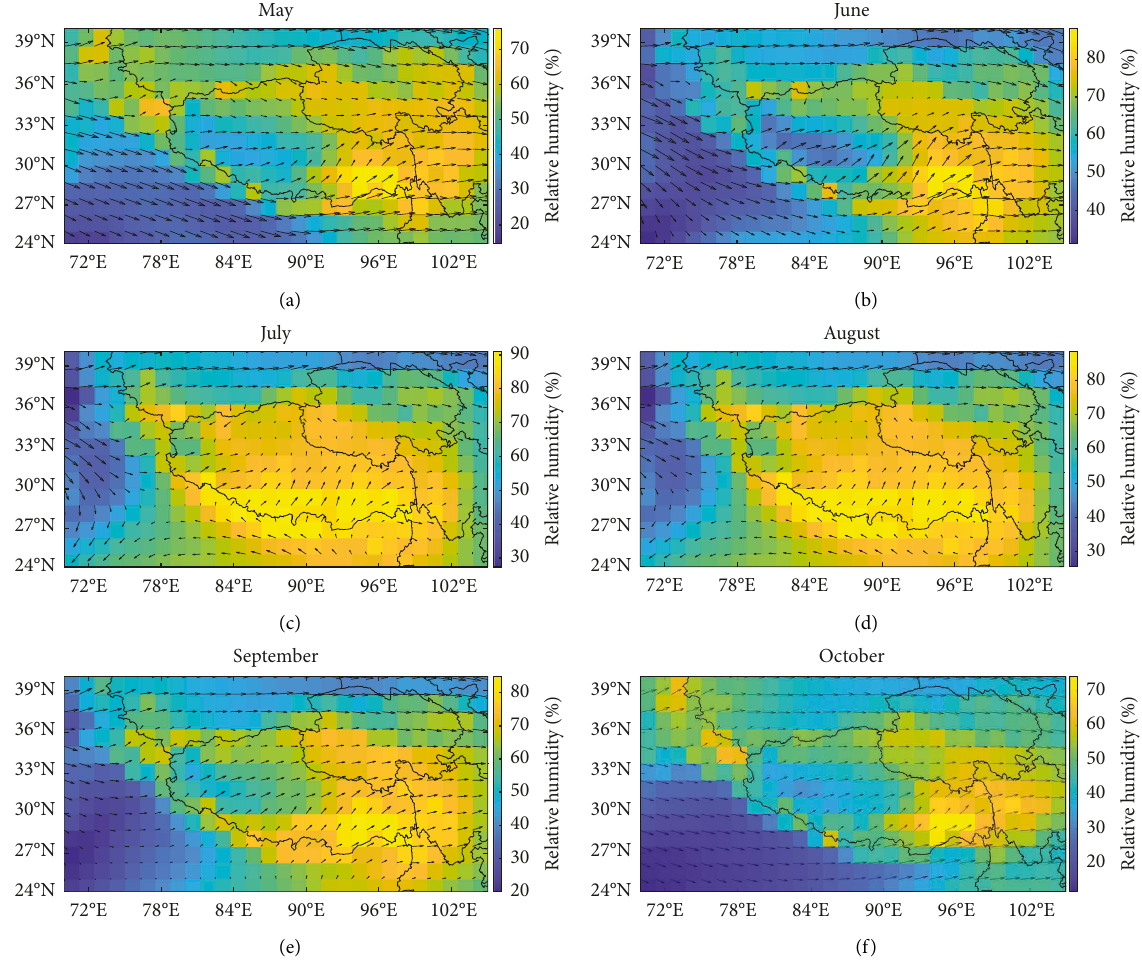
Figure 10: Average wind fields from (a) May to (f) October during 2009–2018. The color-filled plots are the average